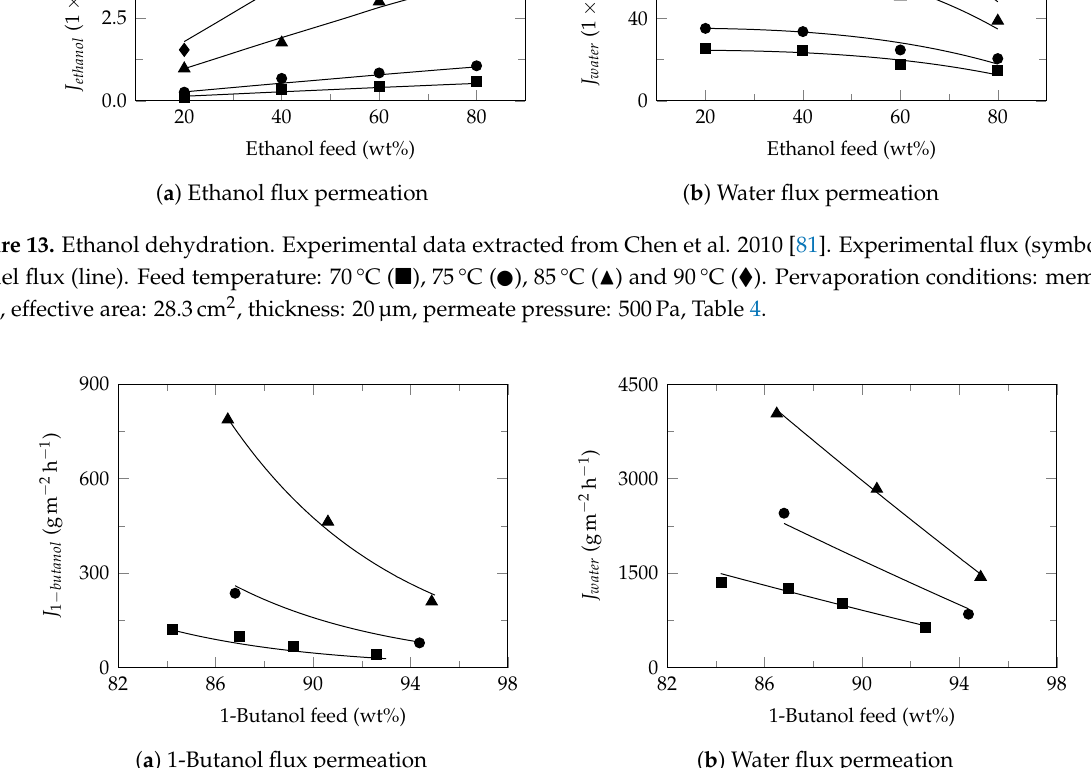
Figure 14. 1-Butanol dehydration. Experimental data extracted from Ashraf et al. 2017 [45]. Experimental flux (symbol) and